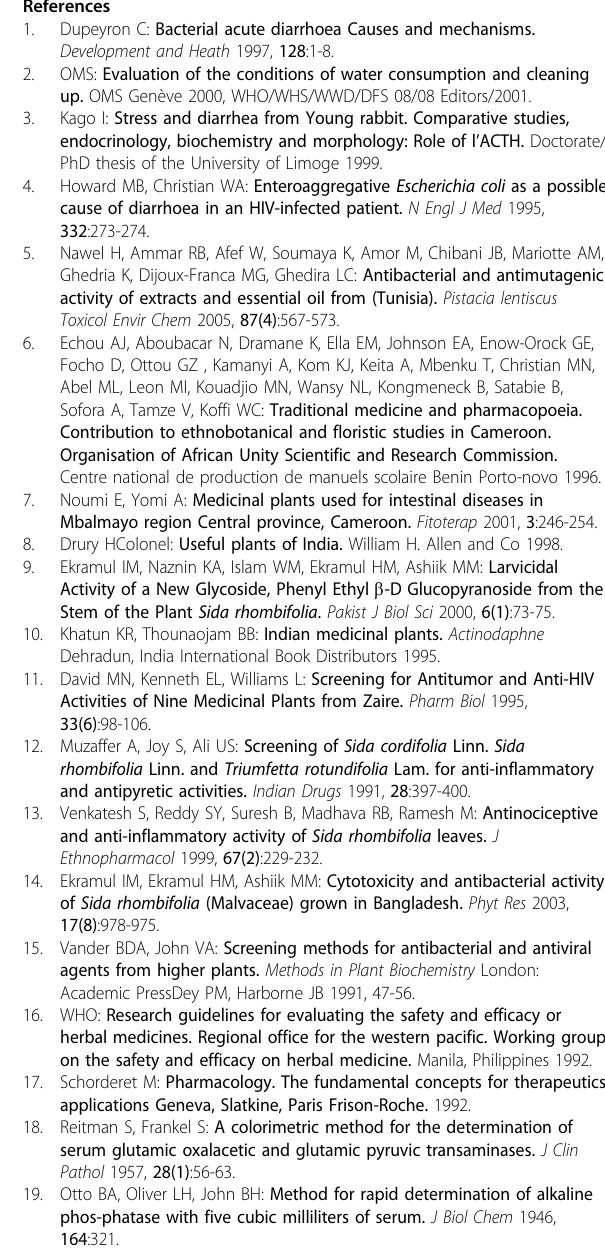
Additional file 1: Table s1: Diameters of inhibition zone of different extracts of S. rhombifolia Linn . This table contents the diameters of inhibition zone of different extracts: MeOH,; water/MeOH (1v:4v); water/ MeOH (1v:1v); water/MeOH (3v:2v); Gent: Gentamycin. All the extracts are tested at 500 μ g/dic and 133 μ g/disc for gentamicin. Additional file 2: Table s2: Diameters of inhibition zone of different concentrations of aqueous methanol (1v:4v) of S. rhombifolia on bacteria . The table shows the diameters of inhibition zone of aqueous- methanol extract (1v:4v) of S. rhombifolia at the concentrations (50 μ g/